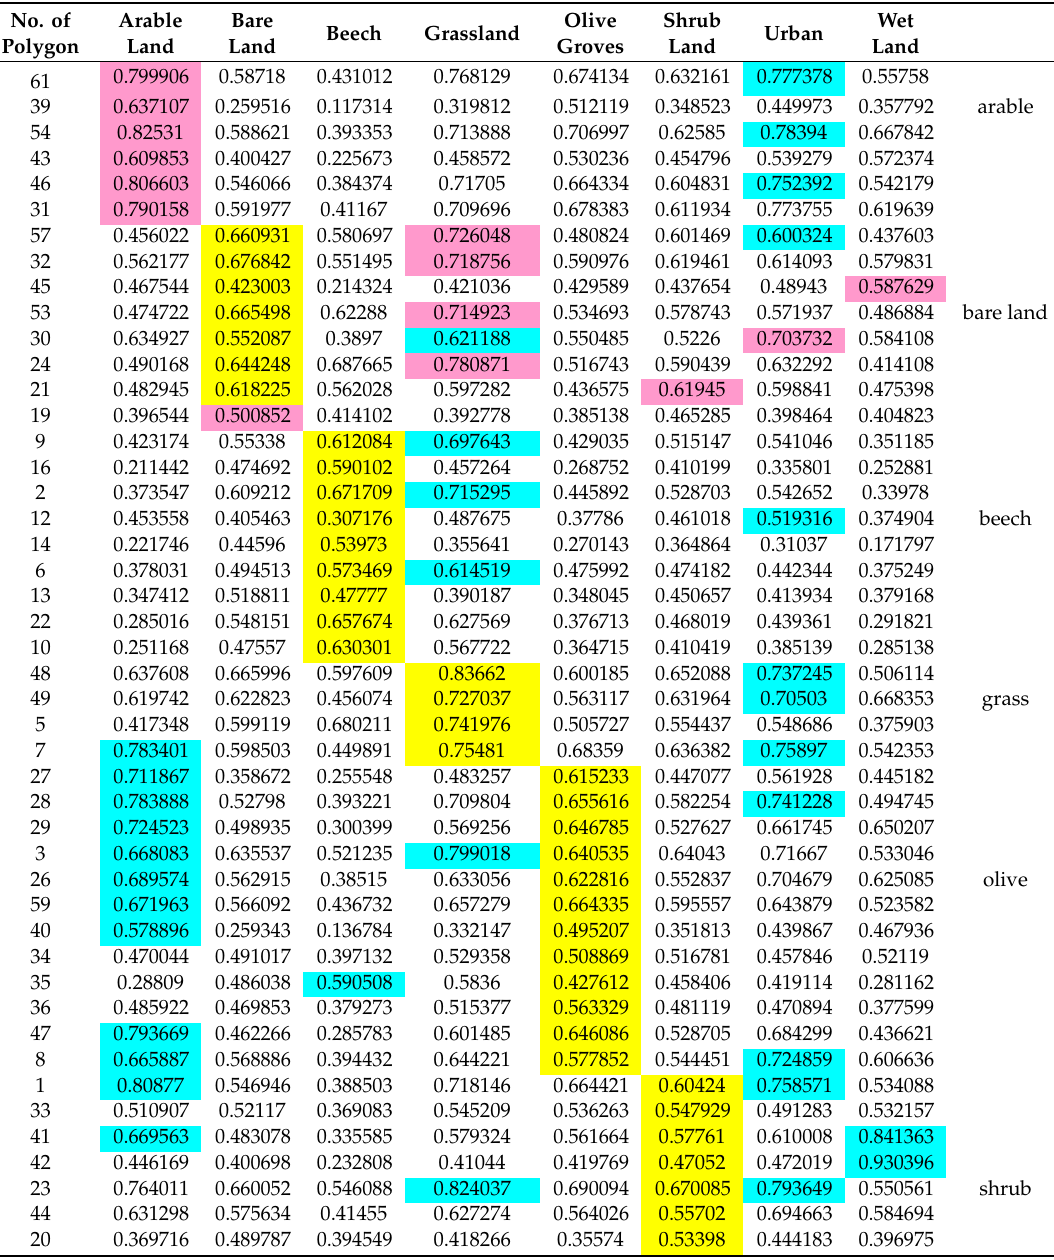
Table 6. The Land Use Land Cover similarity